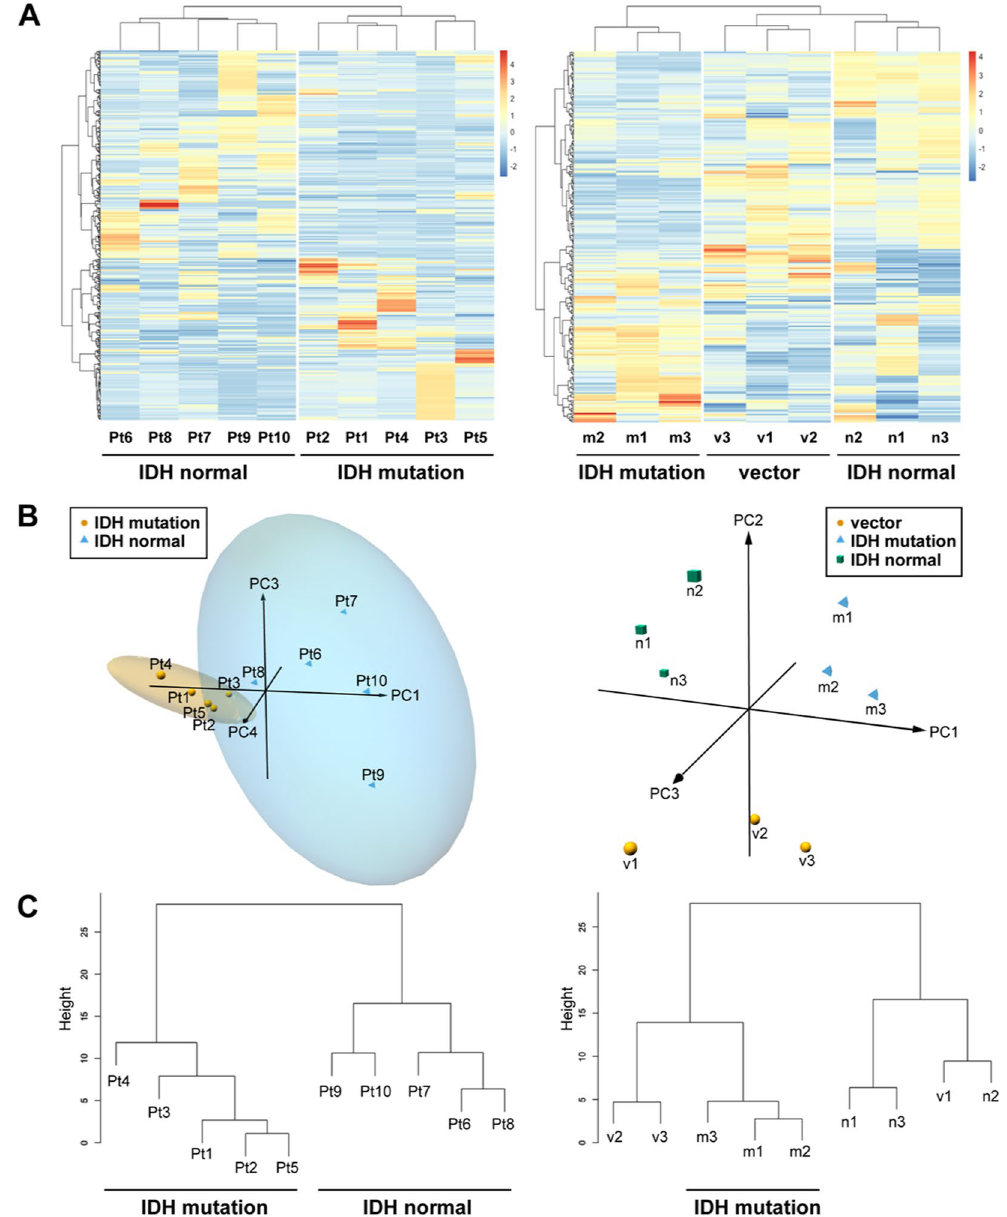
Figure 1. Heat map, Principal component analysis and Hierarchical clustering dendrogram in IDH mutant/ normal gliomas. ( A ) The clustered heat map shows 396 biochemicals in lysates from five replicates each of IDH mutant glioma tissues (Pt1–Pt5) and normal IDH tissues (Pt6–Pt10) (Left). The heat map for U87 glioblastoma cells shows 261 biochemicals in triplicate lysates from cells expressing IDH1 mutation (m1–m3), normal IDH1 (n1–n3), or vector alone (v1–v3) (Right). ( B ) 3D plot of principal component analysis (PC Analysis) with fitted ellipses for the biochemicals in the major class category of The Human Metabolome Database (HMDB 3.0) (151 and 115 biochemicals in glioma tissues and U87 cells, respectively). PC1, PC3 and PC4 for glioma tissues (left, PC2 was omitted from the analysis as it did not show any relevant clustering information), and PC1, PC2 and PC3 for U87 cells (right) were plotted. In each group of glioma tissues, 95% confidence interval ellipsoid was illustrated. ( C ) Hierarchical clustering dendrogram obtained from the three principal components described in